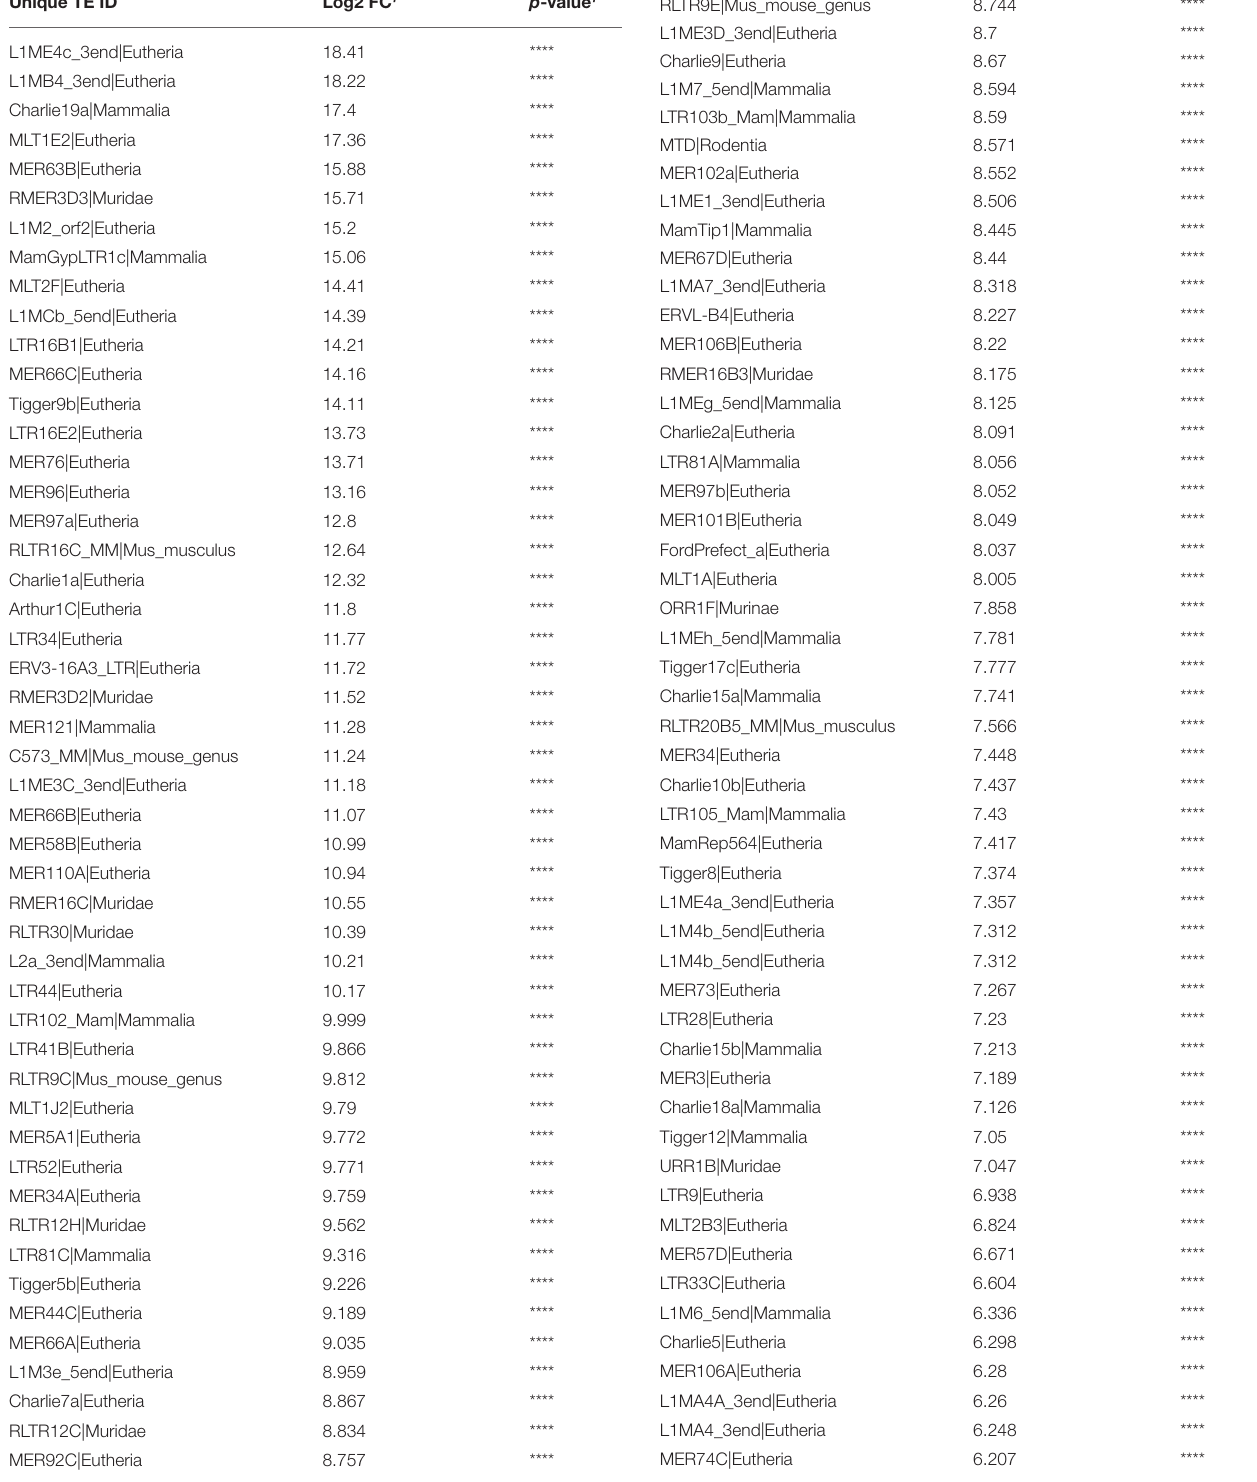
TABLE 1 | Fold change (FC) in significantly increased transposable elements (TE) during transition from acinar-to-ductal metaplasia (ADM) to pancreatic ductal adenocarcinoma